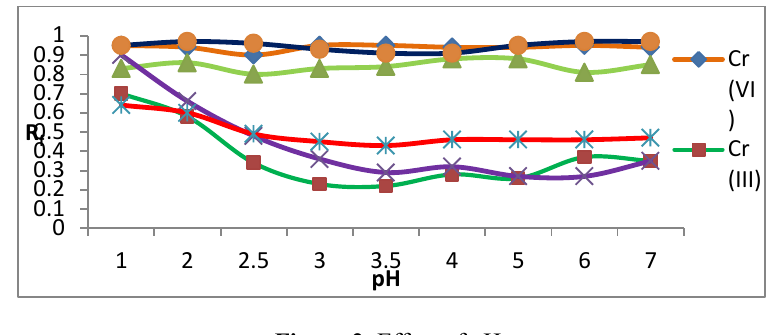
Figure 2. Effect of pH.